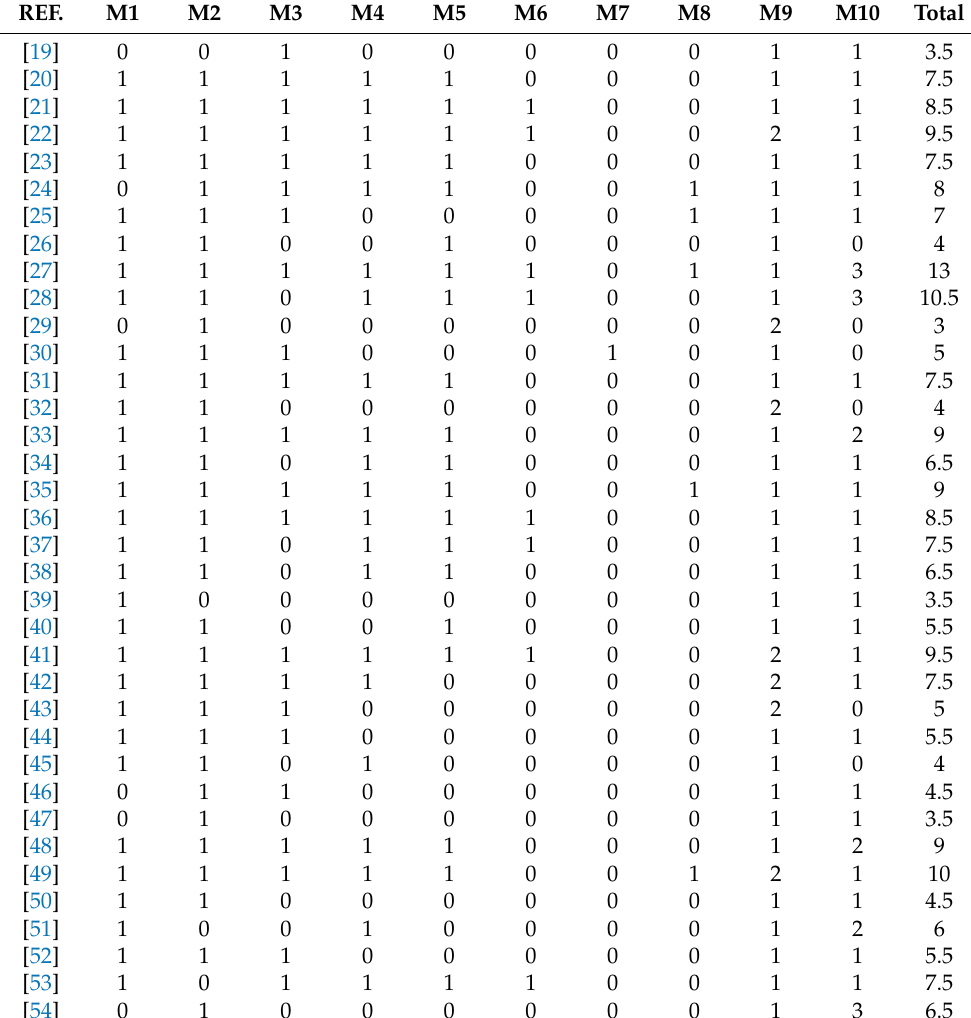
Table A2. Assessment of articles using quality metrics.